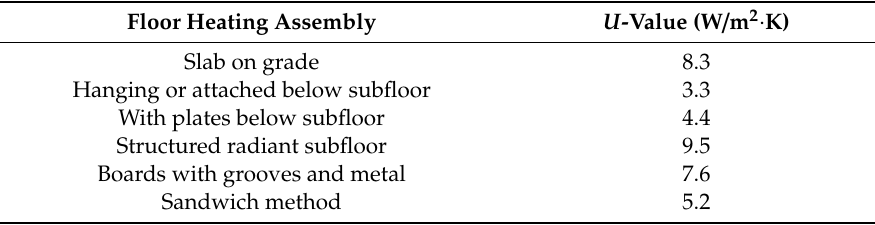
Table 7. Studied floor heating assembly configurations and corresponded U